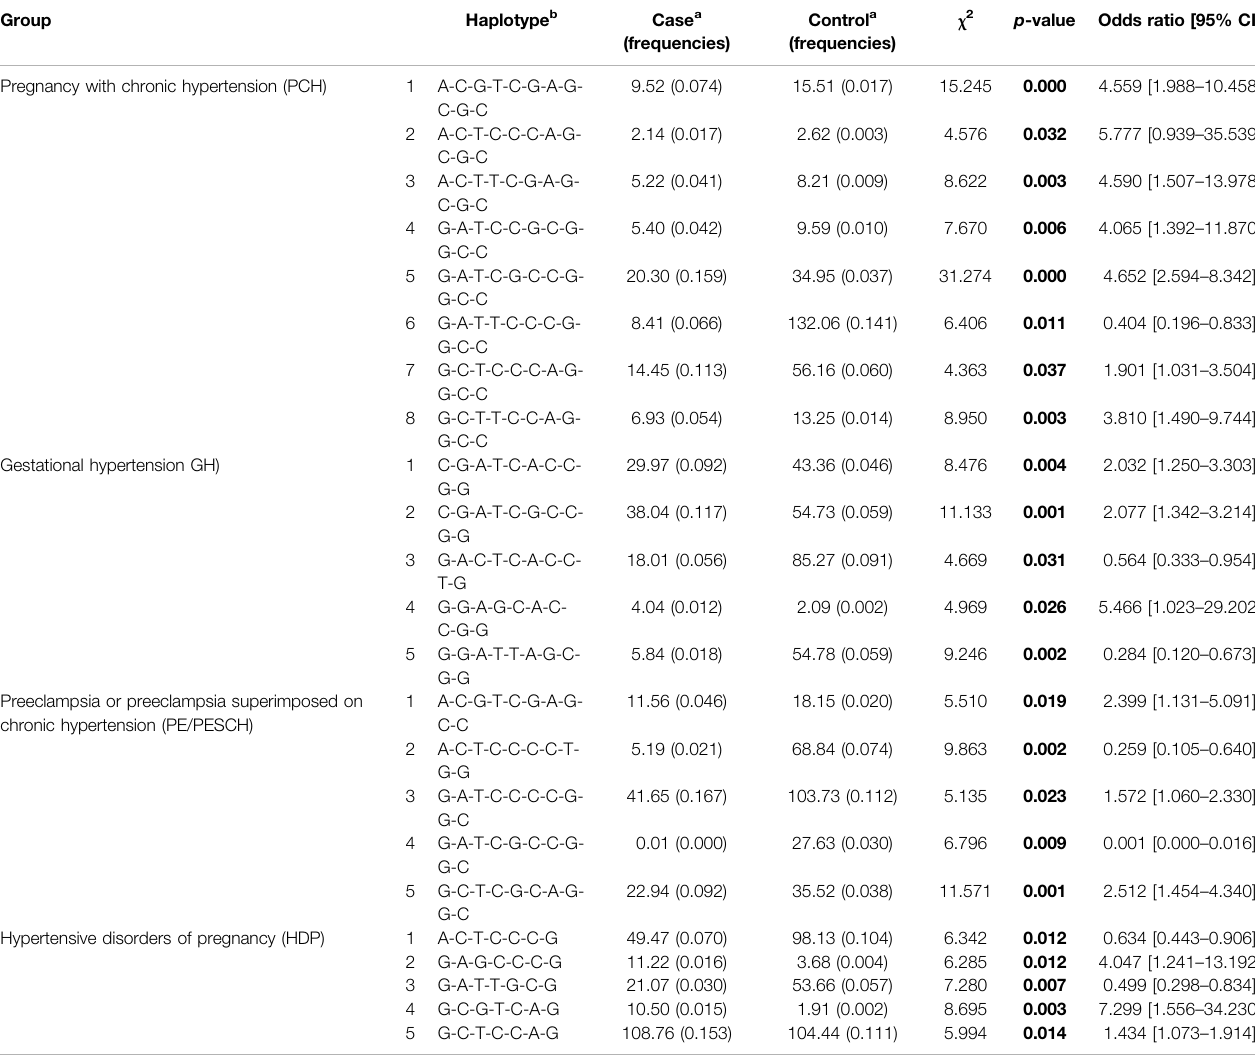
TABLE 5 | Haplotype analysis of designated variations in MT genes among cases and controls.